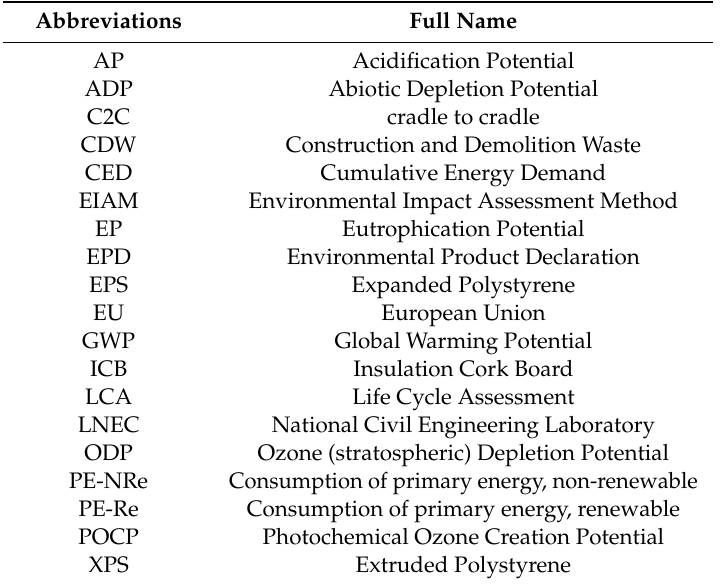
Table A1. The following abbreviations are used in this